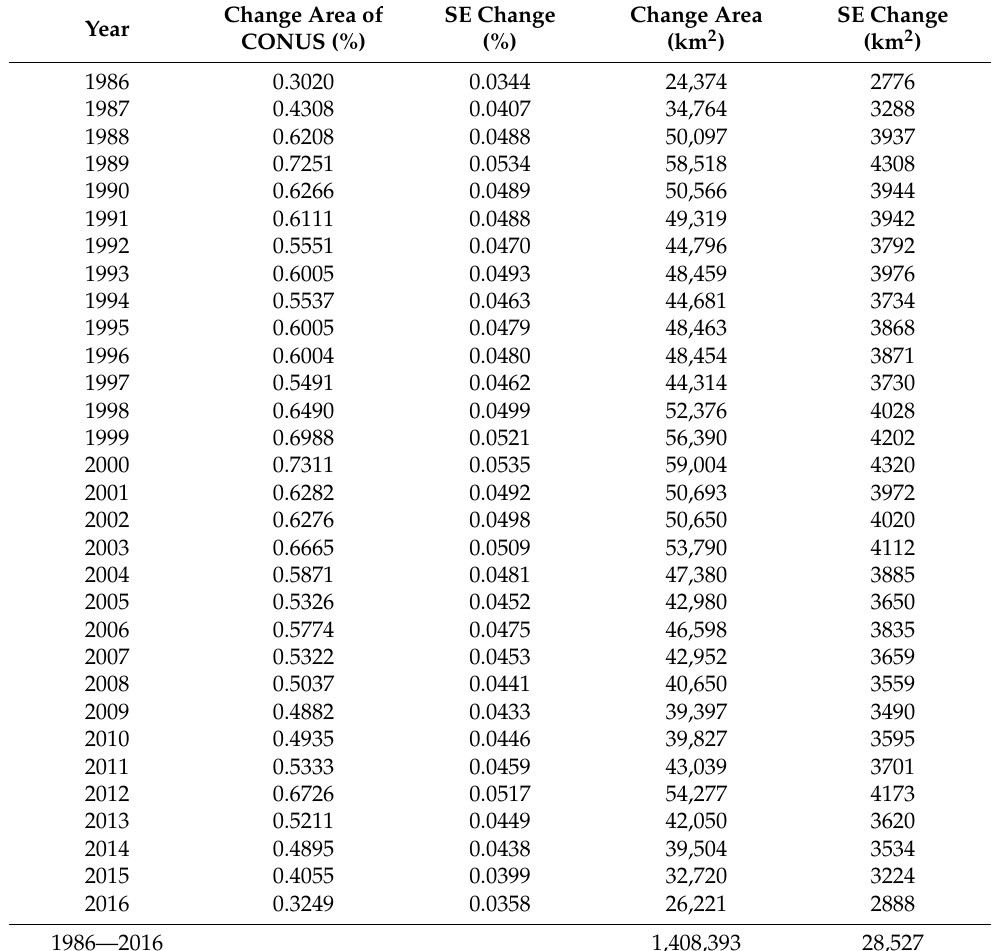
Table 3. Estimated annual rate of land-cover change based on binary change/no-change classes derived from LCMAP annual land-cover change product values for all years during 1986–2016, with 1986 “change year” starting on 1 July 1985. The final row gives the total estimated area of gross change over the entire time